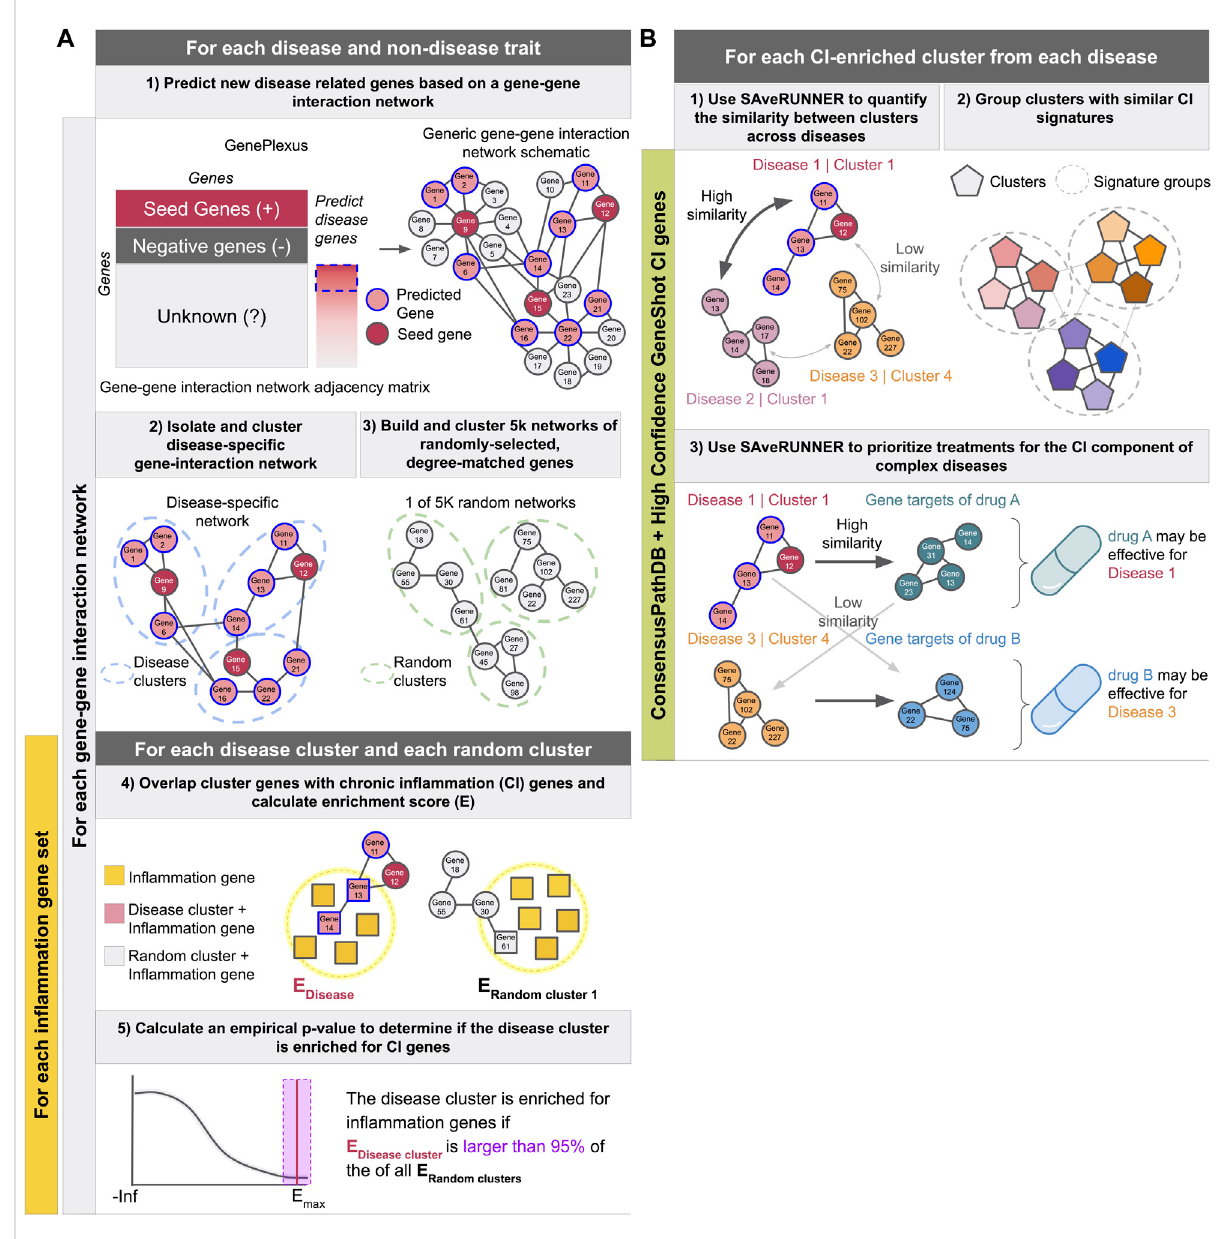
FIGURE 1 Schematics describing the experimental pipeline. (A) Describes predicting new disease related genes (step 1), clustering the disease-speci fi c interactionnetwork(step2)aswellas5,000networksmadefromrandomly-selecteddegree-matchedgenesforeachdisease(step3),identifyingCI- enriched clusters (steps 4 and 5), and calculating the proportion of diseases with at least one CI-enriched cluster. These steps were performed for each gene-gene interaction network in combination with each in fl ammation gene set described in the methods. (B) Describes using SAveRUNNER to fi nd groups of CI-enriched clusters from all diseases with similar CI-signatures (steps 1 and 2), and prioritize treatments for the CI component of complex diseases (step 3). Using ConsensusPathDB with the high-con fi dence GeneShot derived CI gene set resulted in the highest proportion of autoimmune diseases and the lowest proportion of non-disease traits with at least one CI-enriched cluster. Therefore, steps one to three were performed with clusters from that network-CI gene set combination